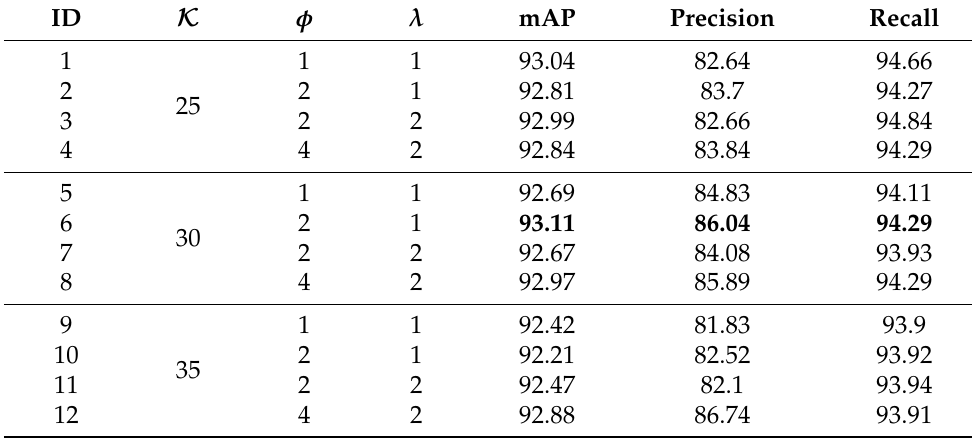
Figure 7. Visualization detection results of the model with and without FAEPN. ( a ) Ground-truth objects. ( b ) Detection results of the baseline. ( c ) Detection results of the baseline with FAEPN. The red bounding boxes denote the ground-truth objects. The yellow bounding boxes denote the detection results. Table 3. Analysis of adaptive sample assignment on the SSDD